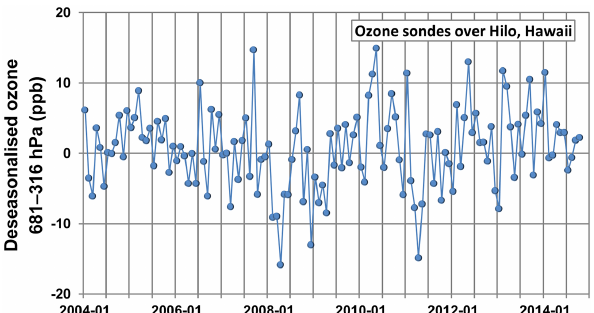
Figure 9. Deseasonalised time series of ozone measured by sondes in the pressure range of 681–316hPa over Hilo,